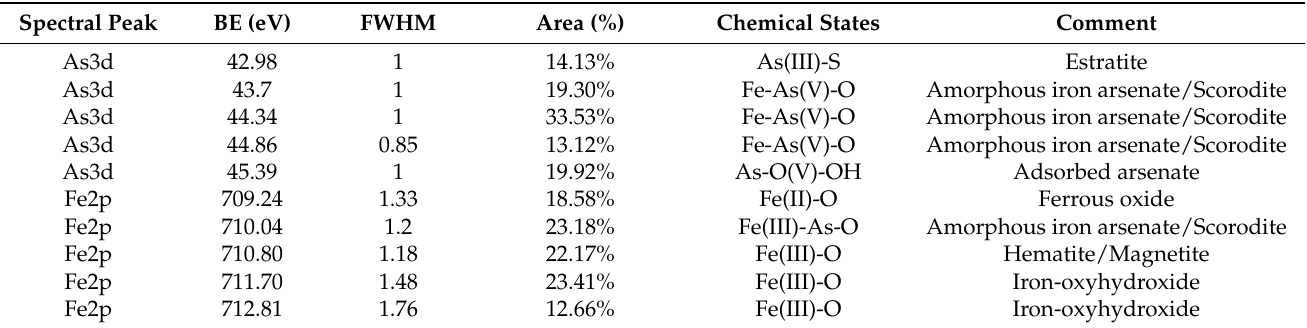
Table 3. XPS data and chemical states of the lead slag.